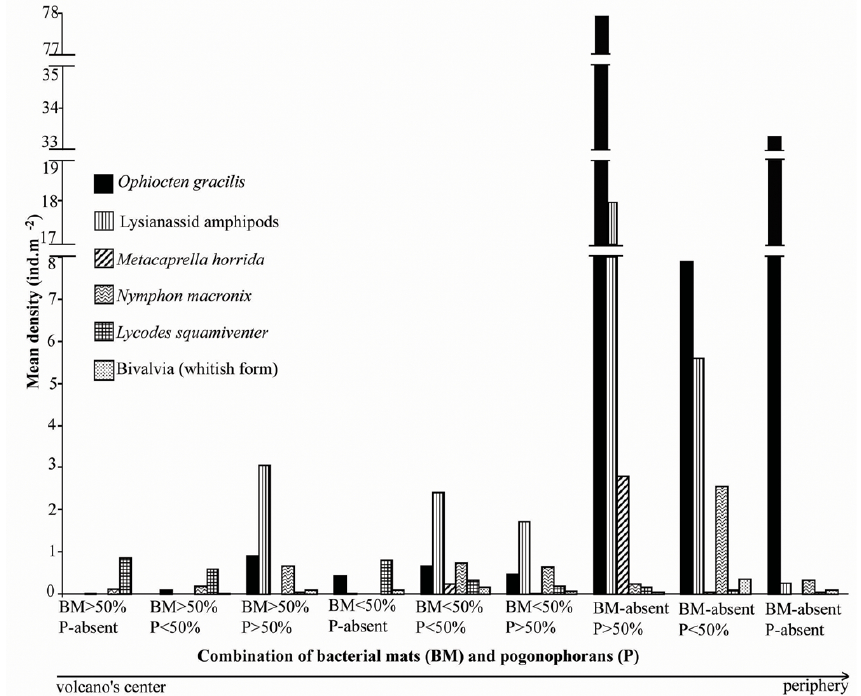
Fig. 5. Mean densities (ind.m − 2 ) of selected taxa in areas with combinations of different coverage by bacterial mats (BM) and pogonophorans (P). Relative location within the volcano caldera is